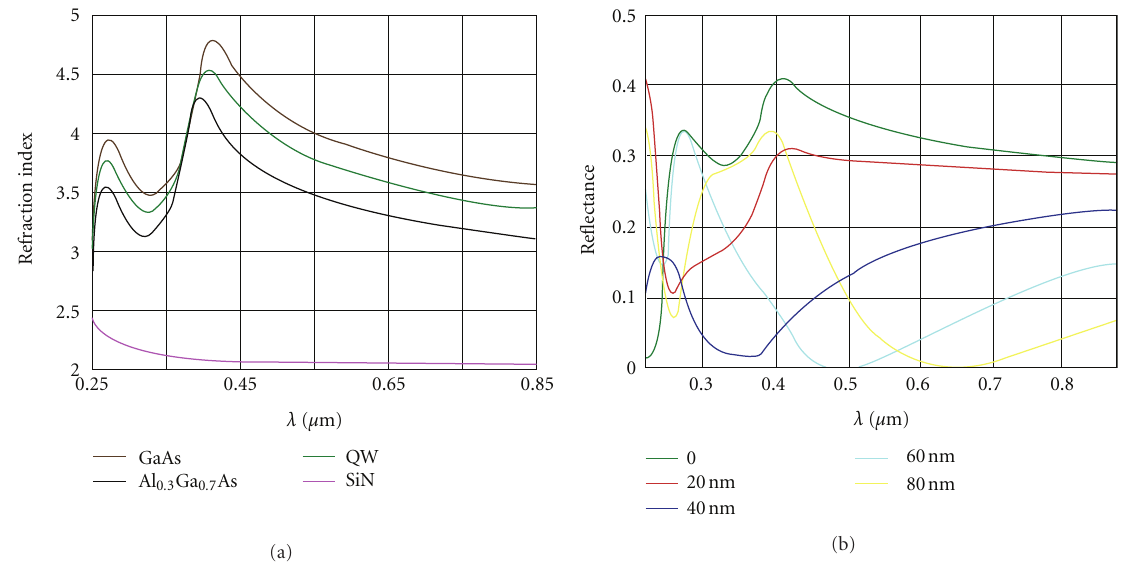
Figure 5: (a) The refraction index for the materials involved in constructing a MQW cell. (b) Spectral reflectance of the MQW cell for di ff erent width (nm) of the antireflecting coating. The HM model was run for GaAs/Al 0 . 3 Ga 0 . 7 As with N w = 30, l w = 20nm and l b = 10 nm.